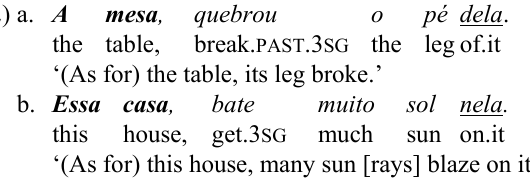
break. PAST .3 SG the leg